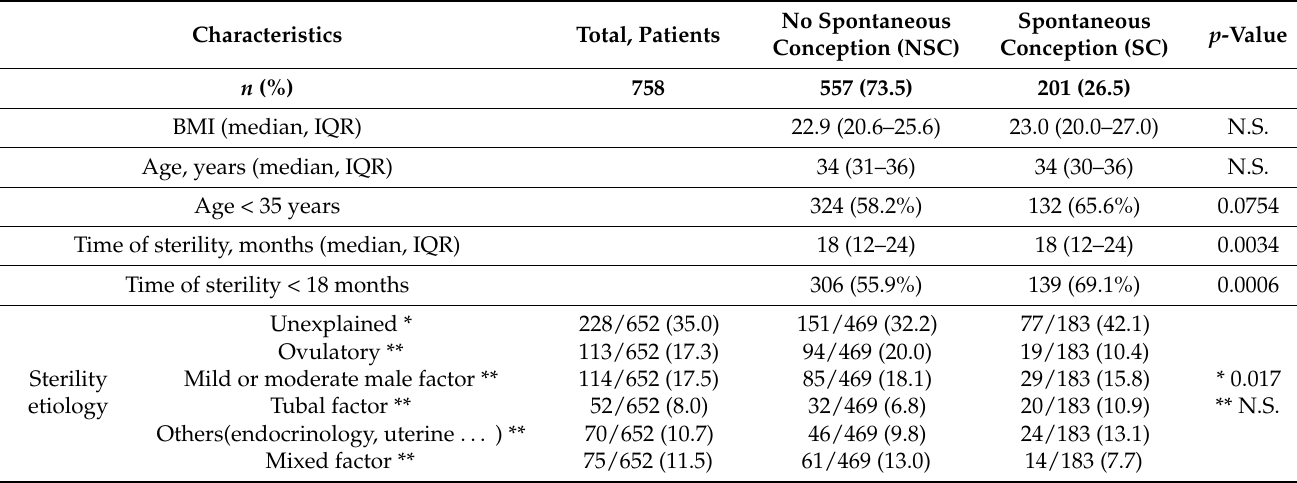
Table 1. Baseline characteristics and fertility